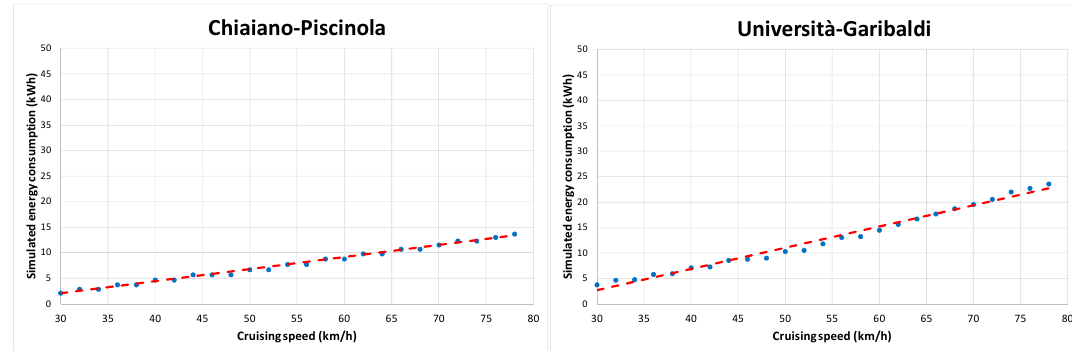
Figure 8. Examples of the relationship between energy consumed and cruising speed.